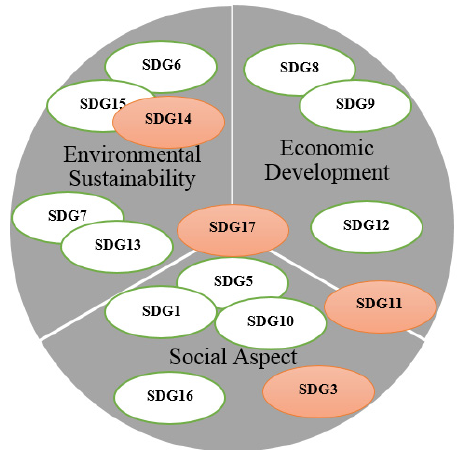
Figure 4. Sustainable development goals in the development of oil and gas potential of the Arctic and its shelf.